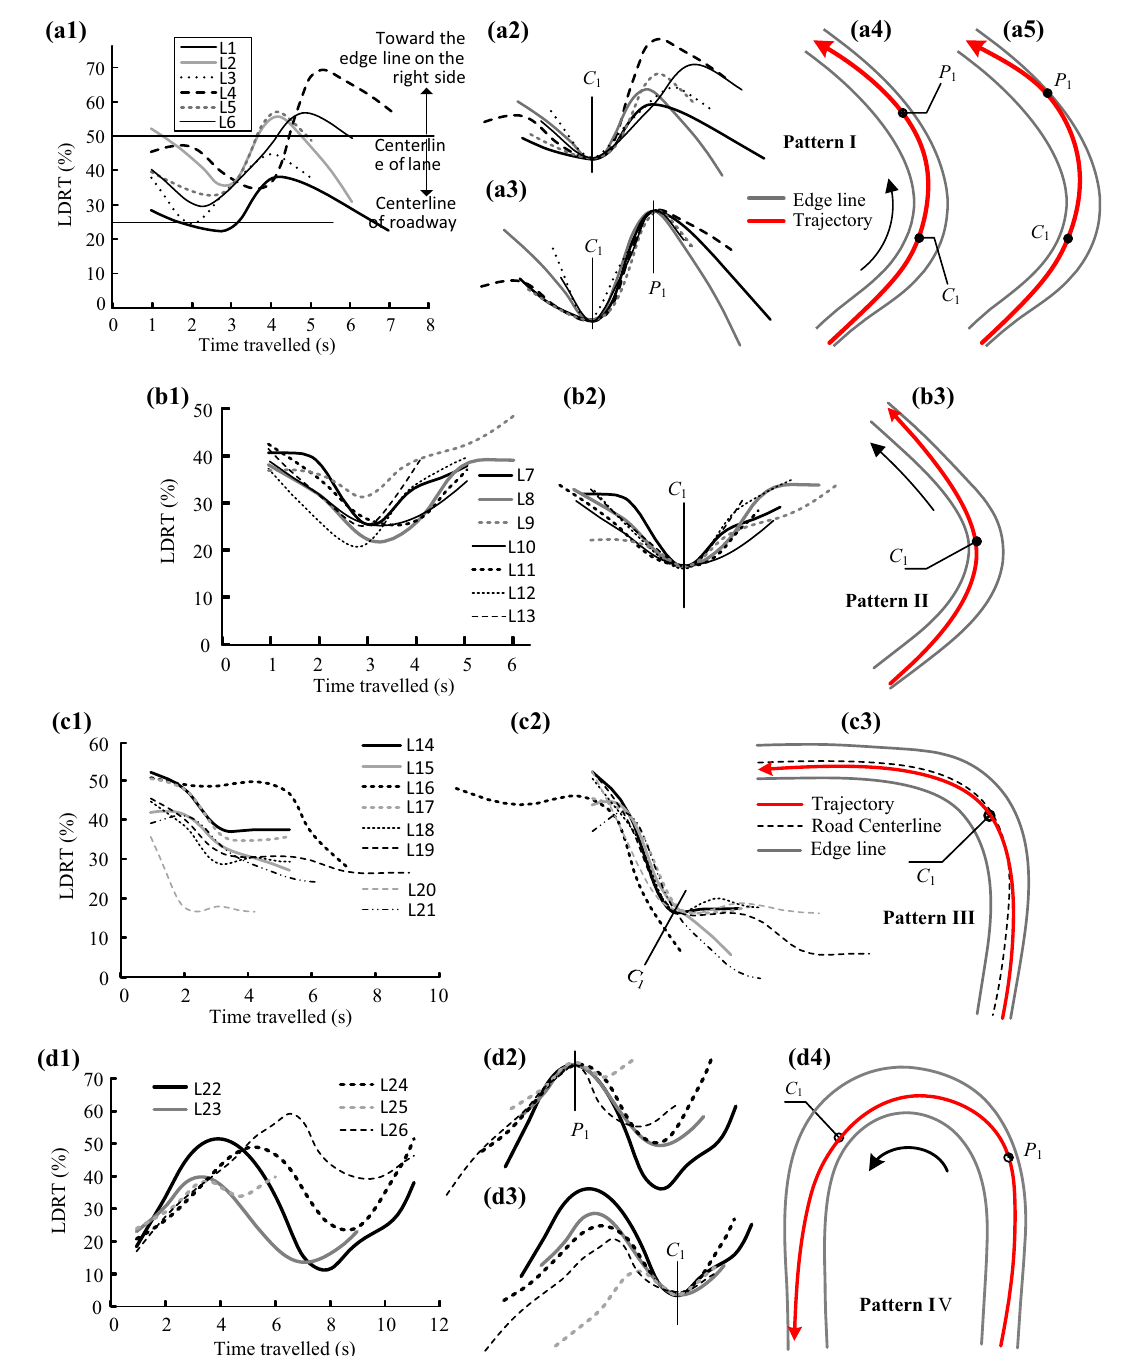
Fig. 6 Trajectory shape of four typical patterns and their corresponding LDRT profiles for left bends: ( a1 - a5 ) Trajectory pattern I on left-hand bends; ( b1 - b4 ) Trajectory pattern II on left-hand bends; ( c ) Trajectory pattern III on left-hand bend; ( d ) Trajectory pattern IVon left-hand